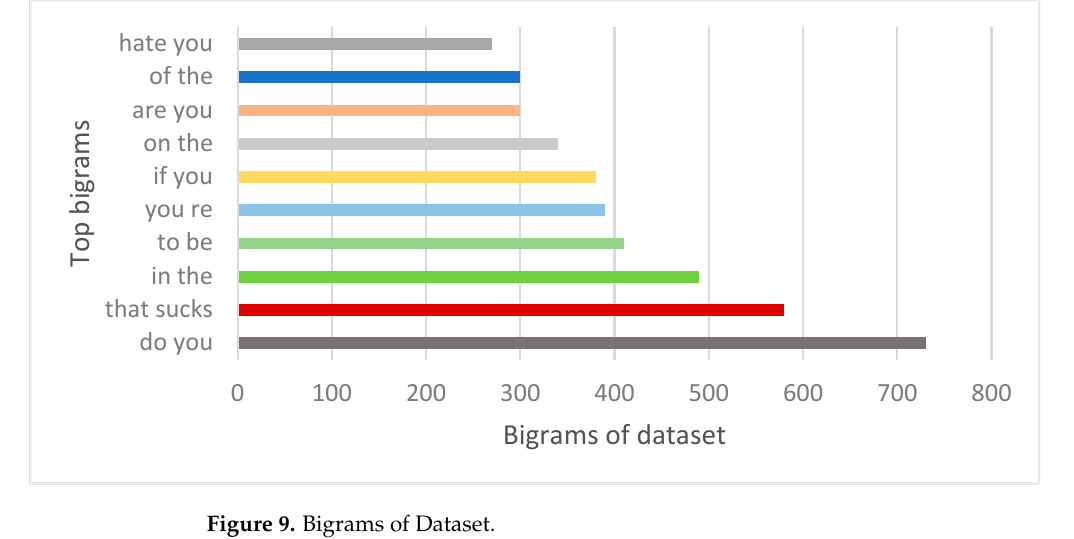
Figure 9. Bigrams of Dataset.